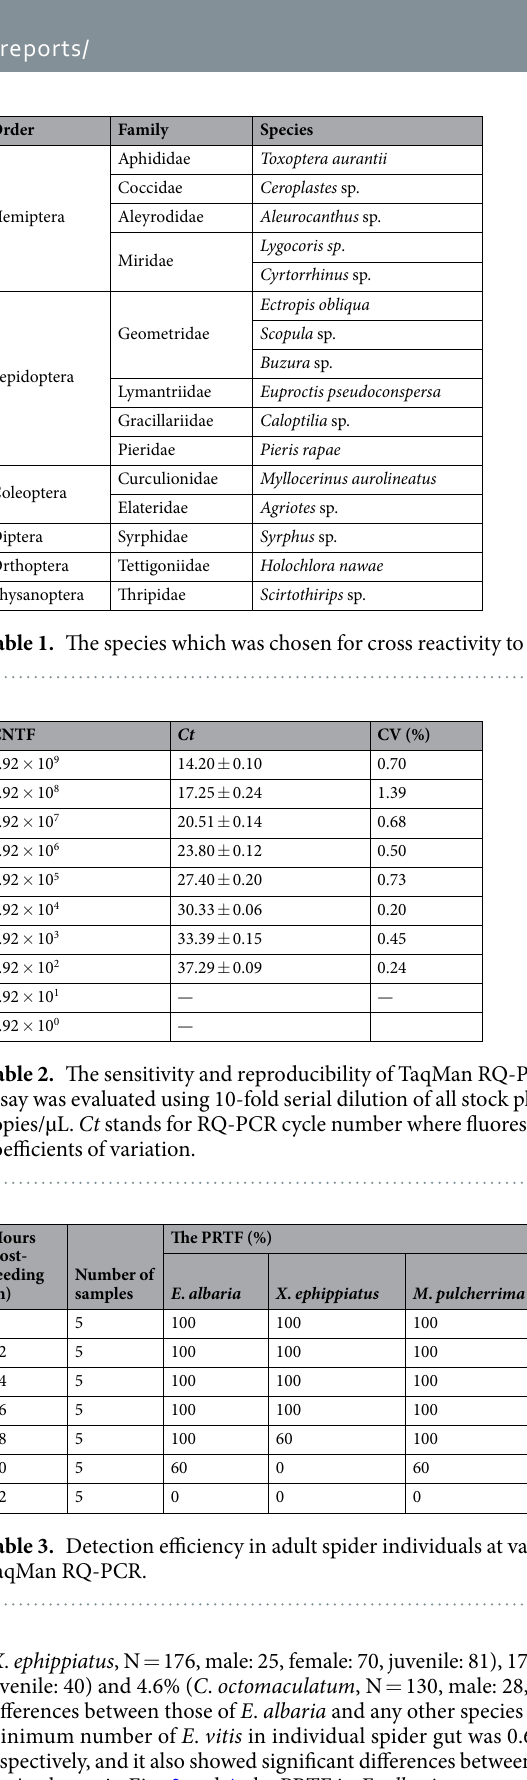
( X . ephippiatus , N = 176, male: 25, female: 70, juvenile: 81), 17.5% ( M . pulcherrima , N = 114, male: 24, female: 50, juvenile: 40) and 4.6% ( C . octomaculatum , N = 130, male: 28, female: 47, juvenile: 55), and it showed significant differences between those of E . albaria and any other species (Table 4). Correspondingly, the average of residual minimum number of E . vitis in individual spider gut was 0.63 ± 0.05, 0.05 ± 0.02, 0.04 ± 0.02 and 0.02 ± 0.01, respectively, and it also showed significant differences between those of E . albaria and any other species (Table 4). As shown in Figs 3 and 4, the PRTF in E . albaria guts was significantly greater than those of any other pred- ators, during the months when E . vitis was most abundant in, May, June, July and September. The residual